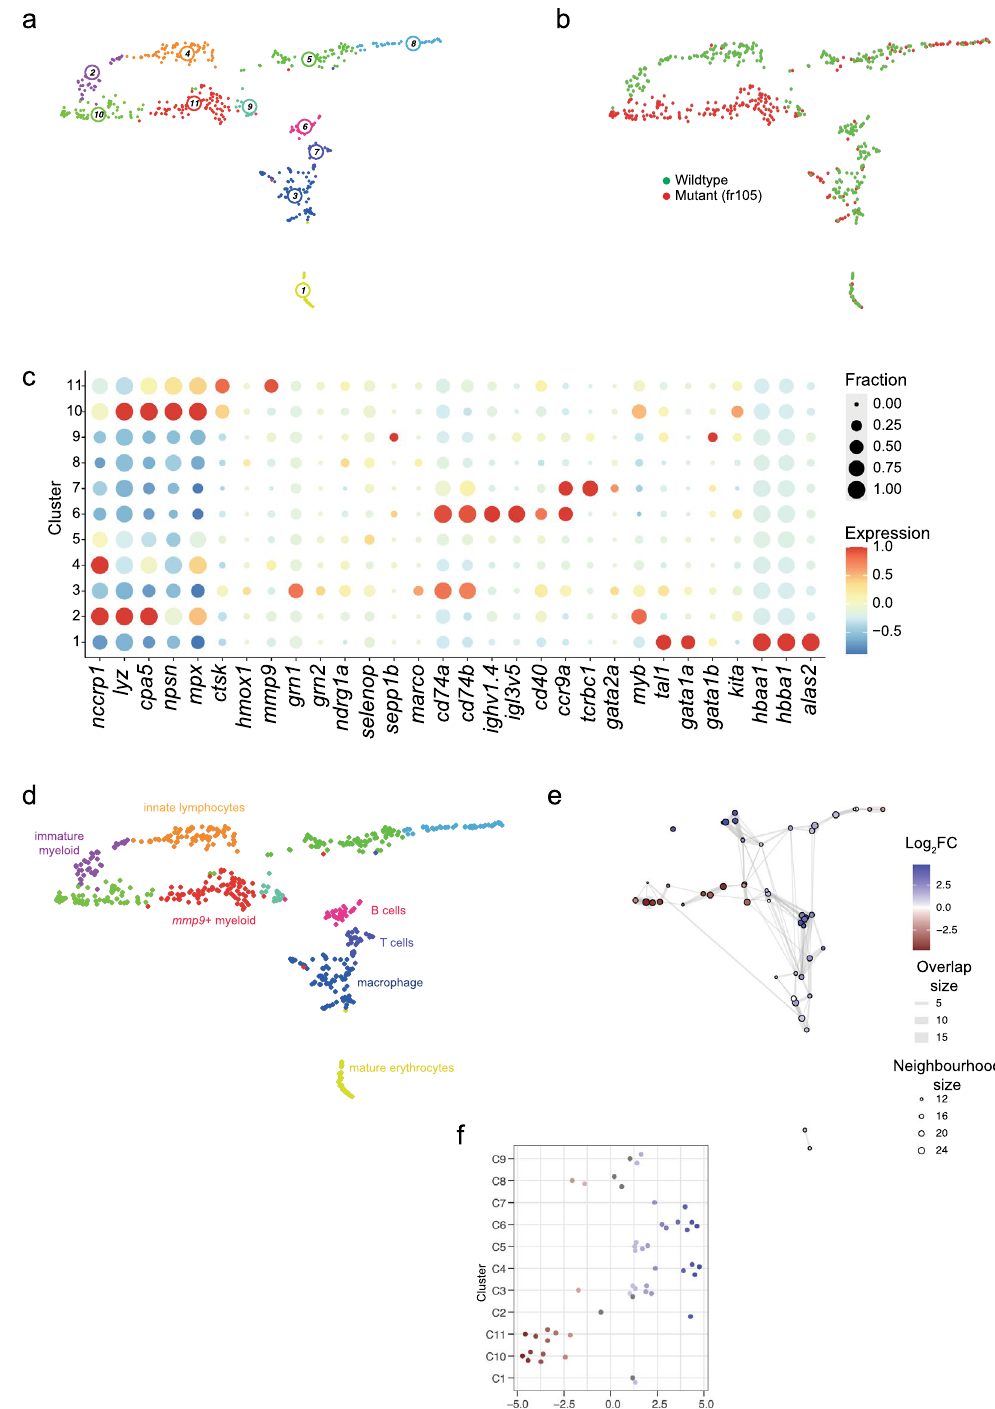
Figure 4. Transcriptional landscape of whole kidney marrow cells of fr105 mutants. ( a ) Uniform manifold approximation and projection (UMAP) representation of transcriptome similarities determined by combined analysis of 341 wild-type and 262 mutant cells of the fr105 line; the individual clusters are indicated by colour and numbers. ( b ) Distribution of wild-type and mutant cells among transcriptionally defined cell clusters; origins of cells are colour-coded. ( c ) Expression pattern of signature genes (listed at the bottom) in the individual cell clusters shown in ( a , b ). Colour represents the z-score of the mean expression of the gene in the respective cluster and dot size represents the fraction of cells in the cluster expressing the gene. z-scores above 1 and below -1 are replaced by 1 and −1, respectively. ( d ) Cell type identification based on signature gene expression patterns (see Table 2, and text for details). ( e ) Graph representation of neighbourhoods identified by the Milo algorithm; see Fig. 3e legend for explanation. ( f ) Bee-swarm plot of differential abundance analysis; see Fig. 3f legend for further